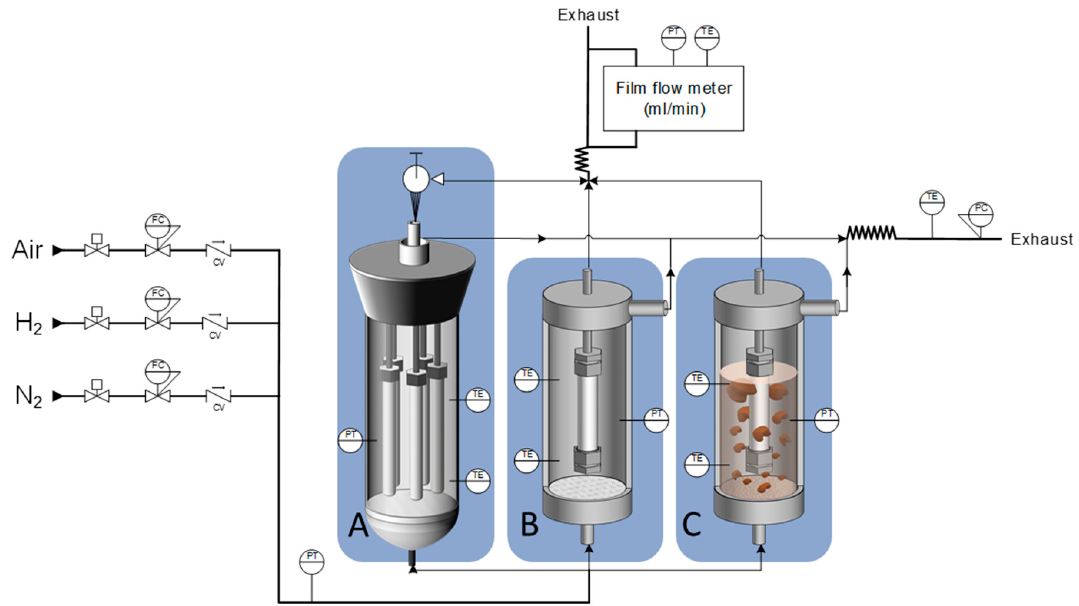
Figure 2. Schematic representation of the permeation modules used in this study.